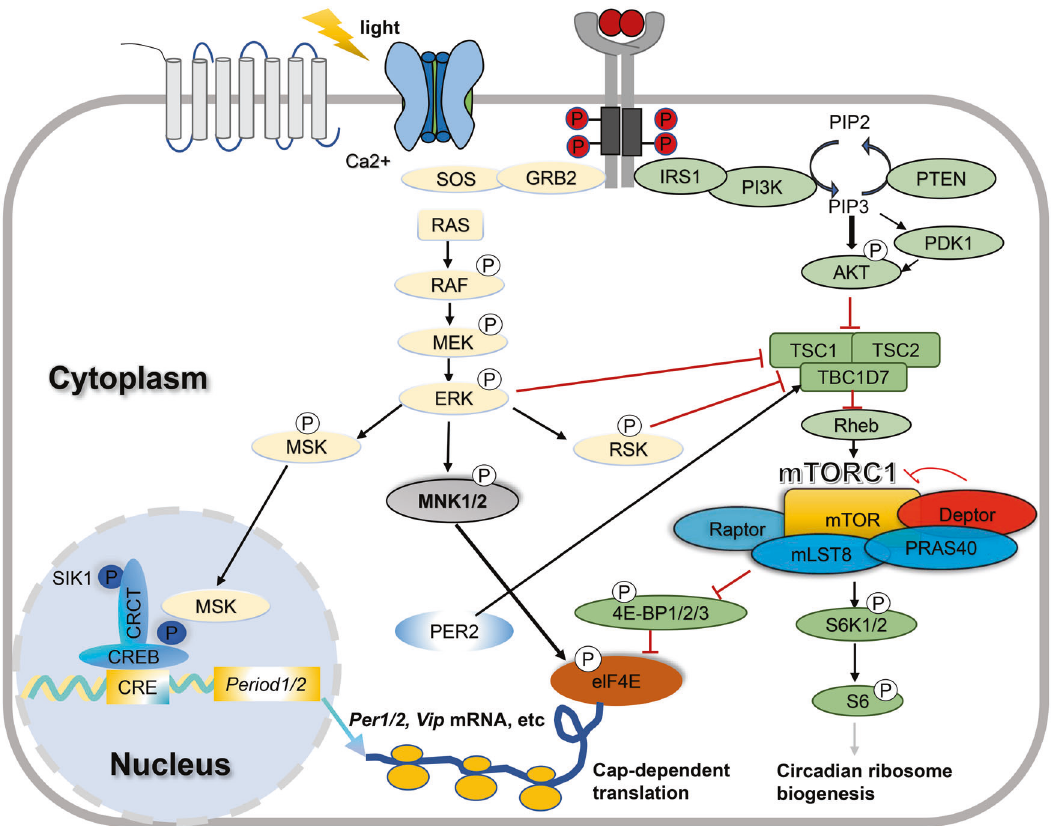
Fig. 3 The interaction between the circadian clock and mTOR-related signaling transduction pathways. Light at night activates ERK MAPK and mTORC1 pathways in the SCN by the neurotransmitter glutamate and PACAP. ERK MAPK in turn activates MSK to phosphorylate CREB and activated Per transcription. ERK MAPK also activated MNK, which in turn phosphorylates the cap-binding protein eIF4E at Ser209 and regulate mRNA translation. The mTORC1 activation also regulates translation through downstream translation pathway effectors such as S6Ks and 4E- BPs, etc. Phosphorylated S6K regulates circadian ribosomal biogenesis. Phosphorylation of 4E-BP activated eIF4E dependent translation. The ERK MAPK and mTOR pathways converge on eIF4E to regulate cap-dependent translation of Per1 , Per2 , Vip mRNAs, which play important roles in photic entrainment of the circadian clock and SCN cell synchronization. Circadian mTOR activities are controlled by the circadian clock via complex mechanisms, one of which may be through the interaction of Per2 with